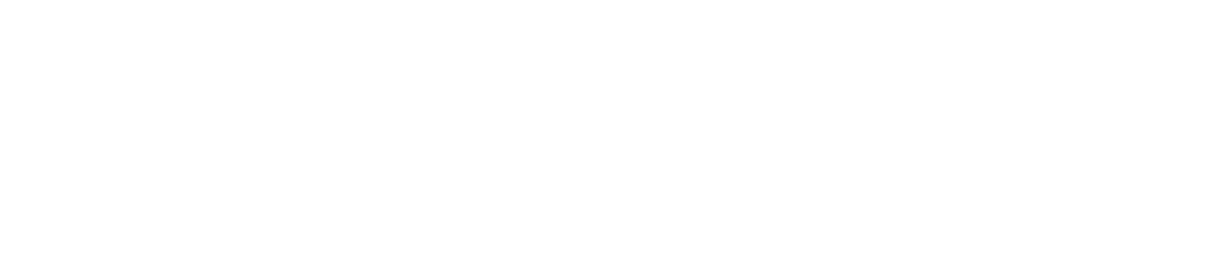
Frontiers in Earth Science |